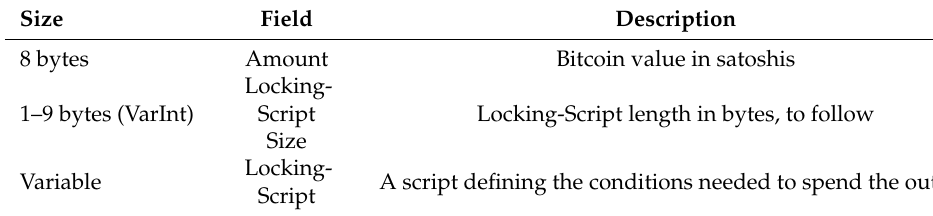
Table 2. The structure of a transaction output in Bitcoin. Size Field